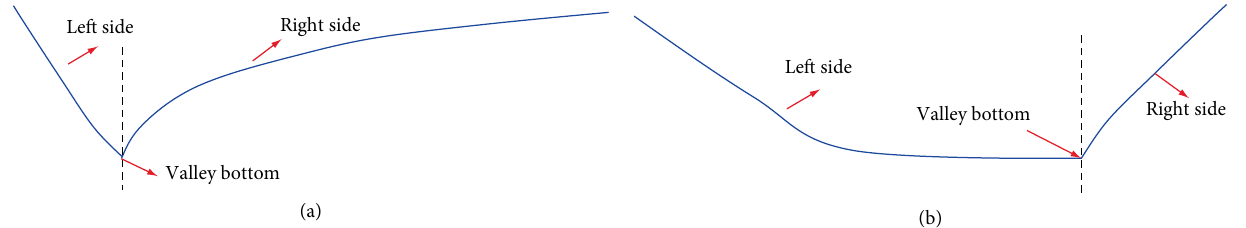
Figure 11: Pressure curves schematic of monitoring points (P2–P8): (a) P2–P6 and (b)